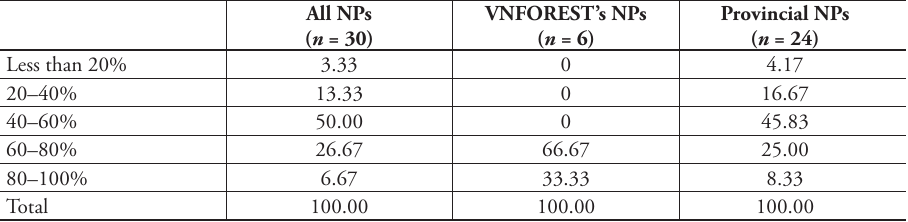
Table 4. Percentages of national parks having investment levels of the total funding for conservation